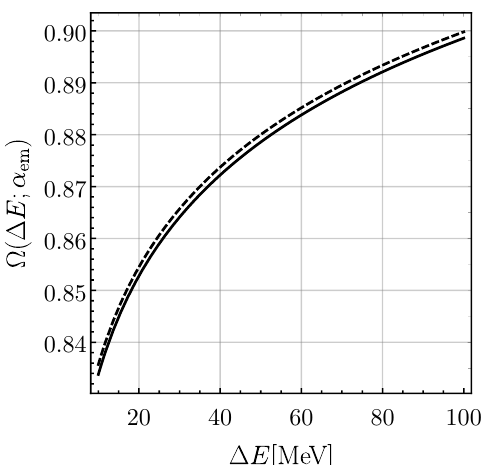
[10 ; 100] MeV for the 2